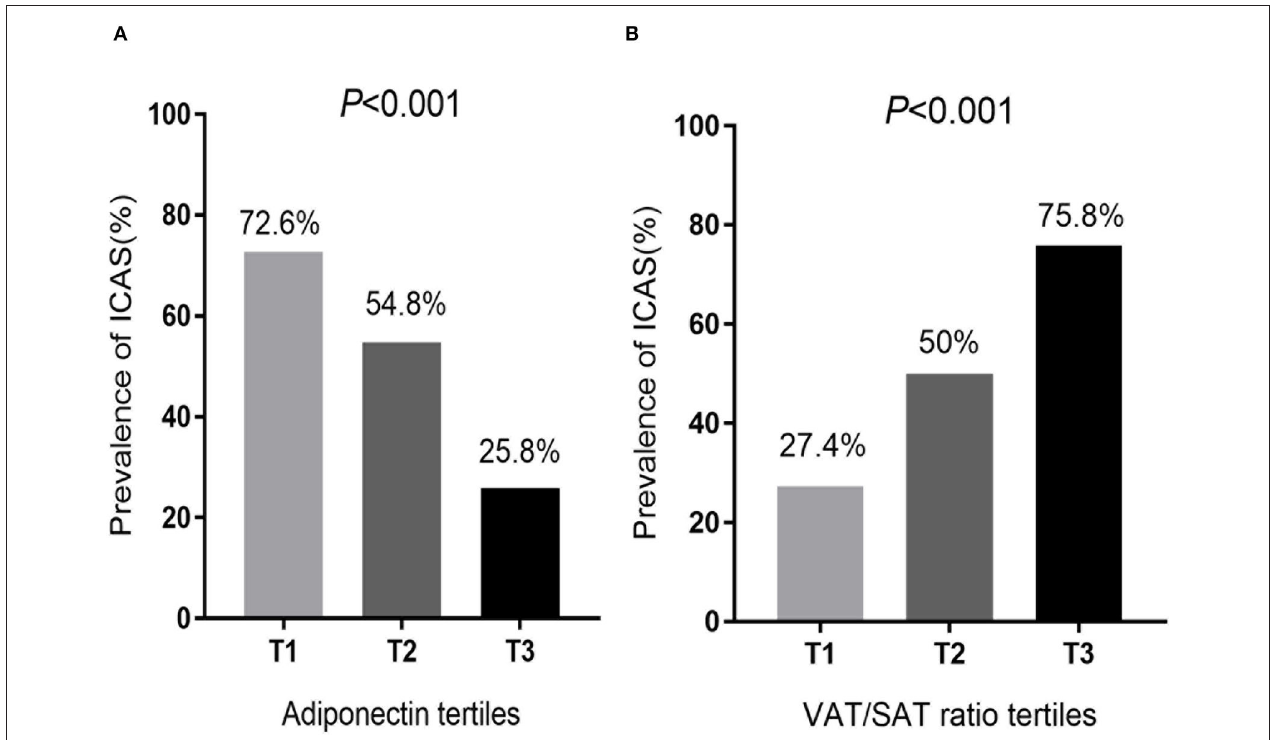
FIGURE 1 | Comparison of (A) adiponectin tertiles and (B) VAT/SAT ratio tertiles determined according to the prevalence of ICAS. (A) Participants were divided into 3 groups, T1: low-adiponectin (0.83–2.09 ug/ml), T2: middle-adiponectin (2.10–3.41 ug/ml), and T3: high-adiponectin (3.42–6.38 ug/ml). (B) Participants were divided into 3 groups, T1: low-VAT/SAT (0.30–0.84), T2: middle-VAT/SAT (0.85–1.13), and T3: high-VAT/SAT (1.14–2.06). VAT, Visceral adipose tissue; SAT, Subcutaneous adipose tissue; ICAS, Intracranial atherosclerotic